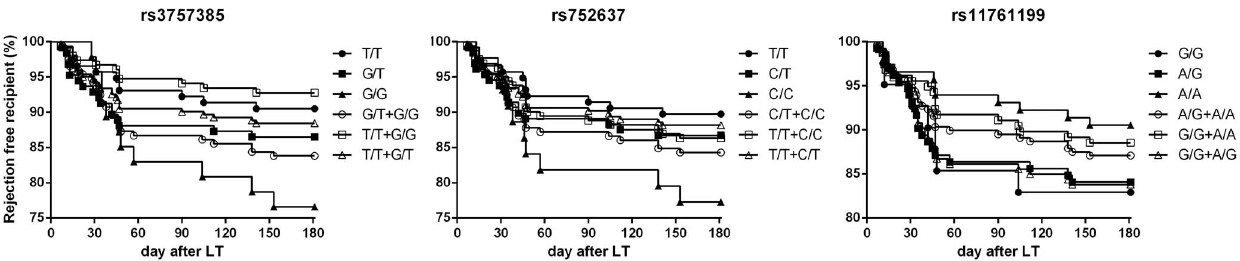
Figure 2. Acute rejection comparisons among SNP groups.